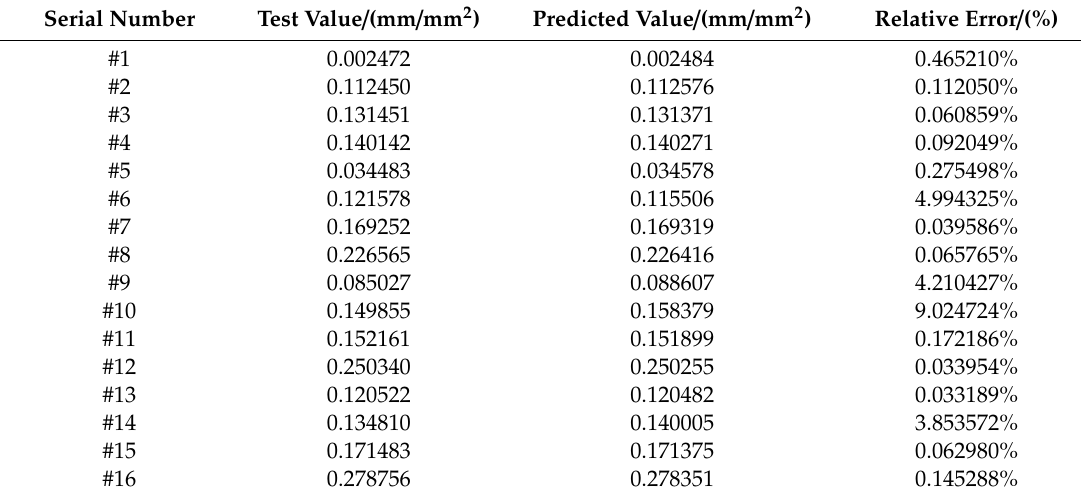
Table 6. Comparison of the predicted and experimental values.